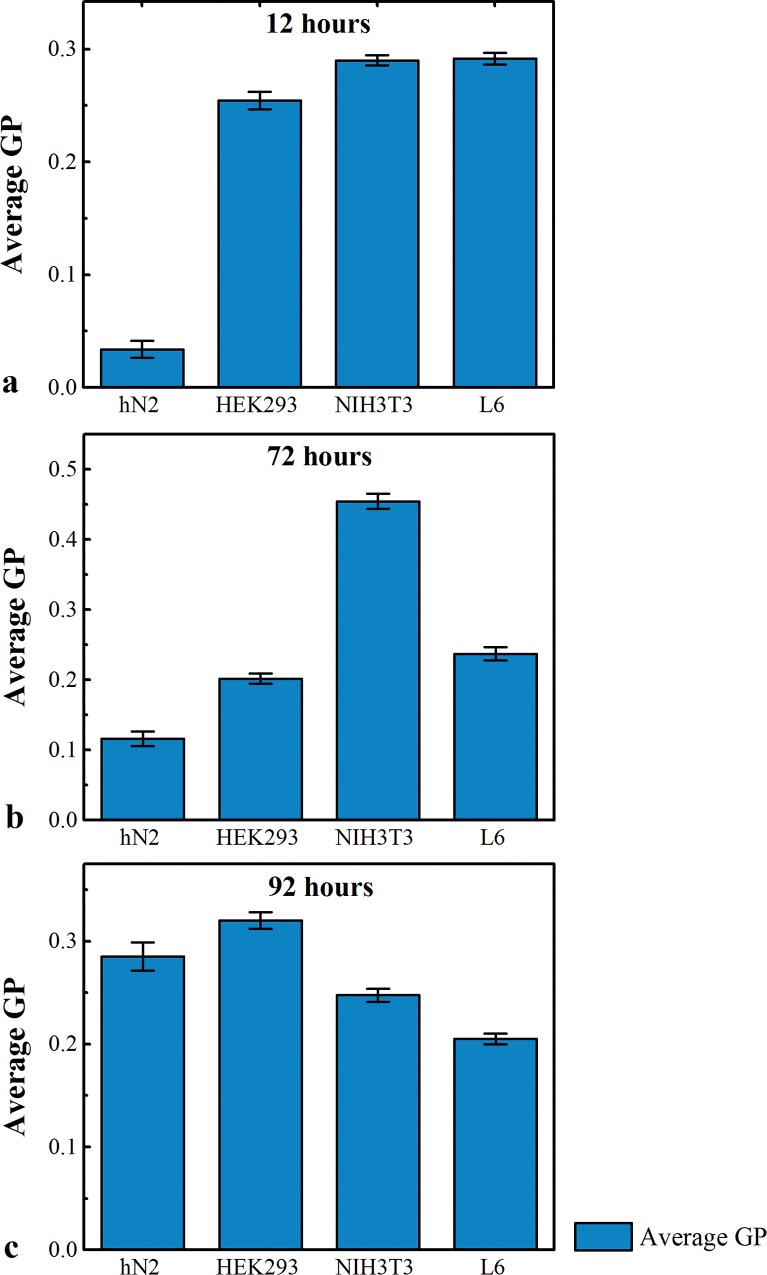
Summary of GP measurements.GP measurements in hN2, HEK293, NIH3T3 and L6 cells at a) 12 h; b) 72 h and c) 92 h.